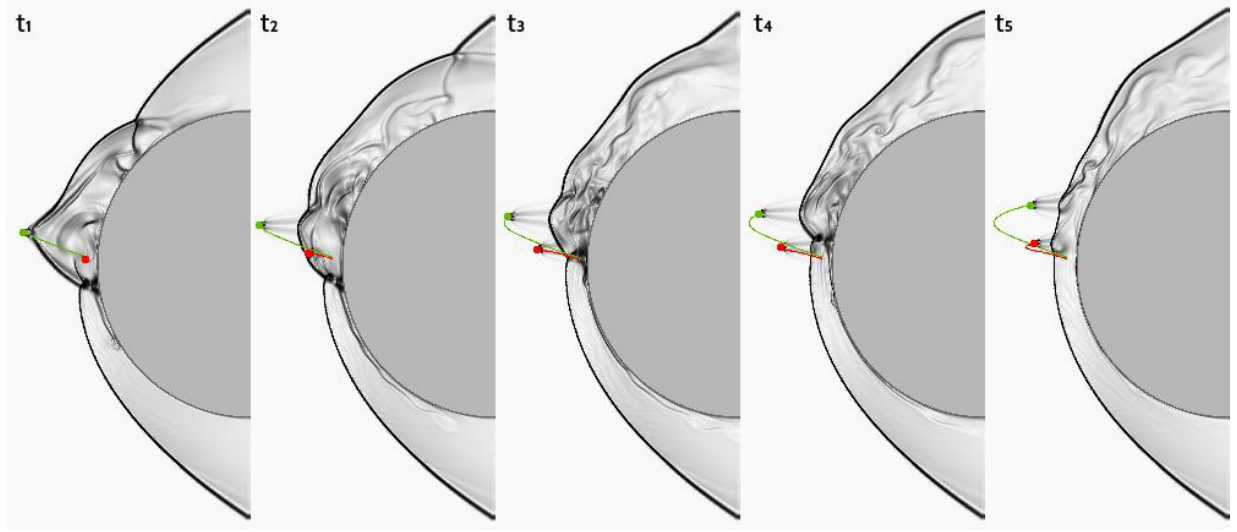
Figure 9. Shadow pictures of the flow under the influence of a pair of particles.